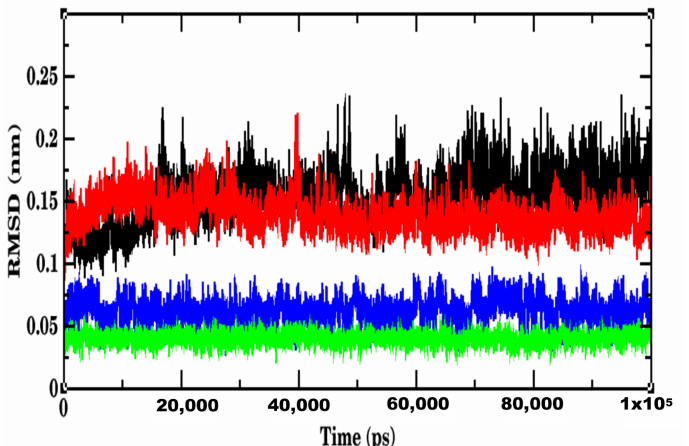
Figure 9. RMSD plot of 100, 000 ps MD simulation showing the trajectory snapshots at different time points. RMSD of protein backbone: the wild-type S RBD-Lupeol complex (black) showed a moderate deviation in the backbone of the protein associated with the complex, when compared to that of the Delta S RBD-Betulin complex (red), RMSD of ligands: the Lupeol that is in complex with Wild-type S RBD (black) showed a moderate deviation, when compared to that of the Lupeol (blue) and Betulin bound to Delta S RBD